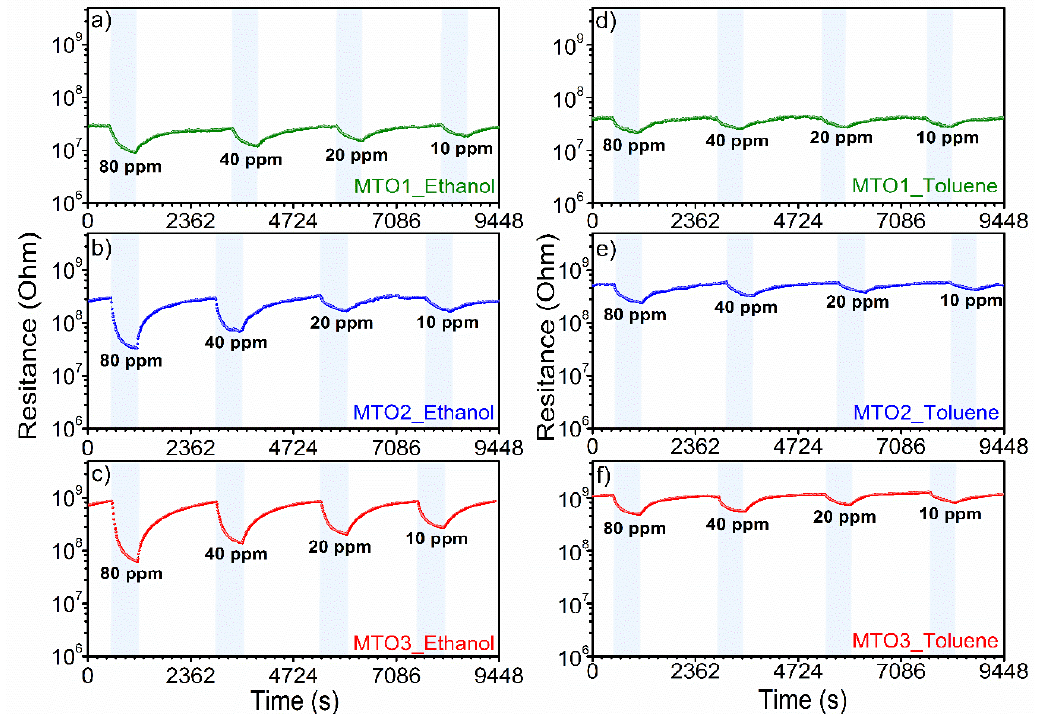
Figure 9. Dynamic response curves of Mg-doped SnO 2 films at different concentrations of ethanol ( left figure ) and toluene ( right figure ).